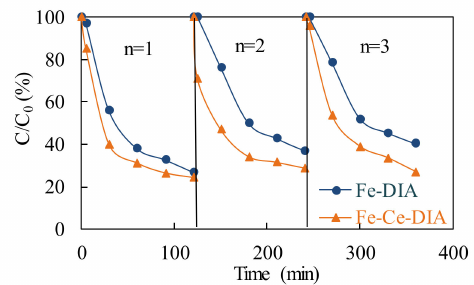
Figure 8. Repeated use of Fe-DIA and Fe-Ce / DIA for TC removal. Conditions: T = 37 ◦ C, 150